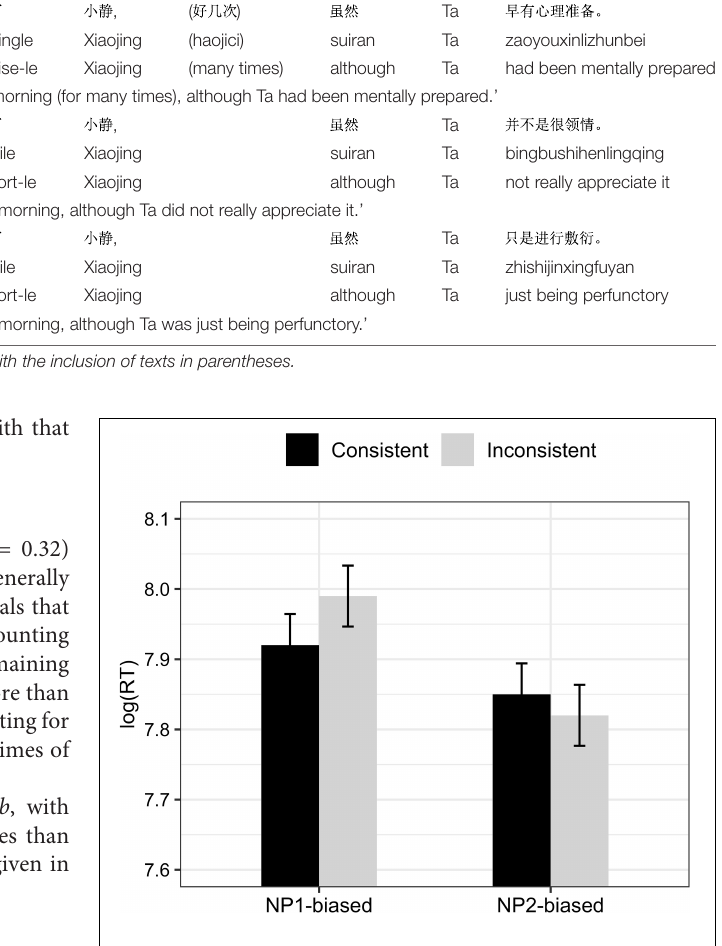
FIGURE 2 | Mean log-transformed response times in each condition of Experiment 2. Error bars represent one standard